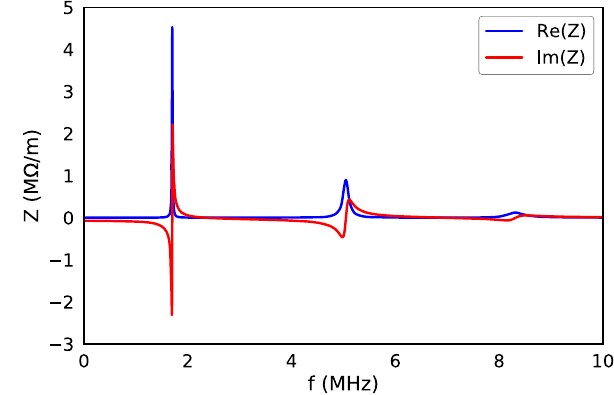
FIG. 12. Horizontal impedance model of the PSB extraction kicker due to coupling with the kicker electrical circuit, including cables as coaxial transmission lines.